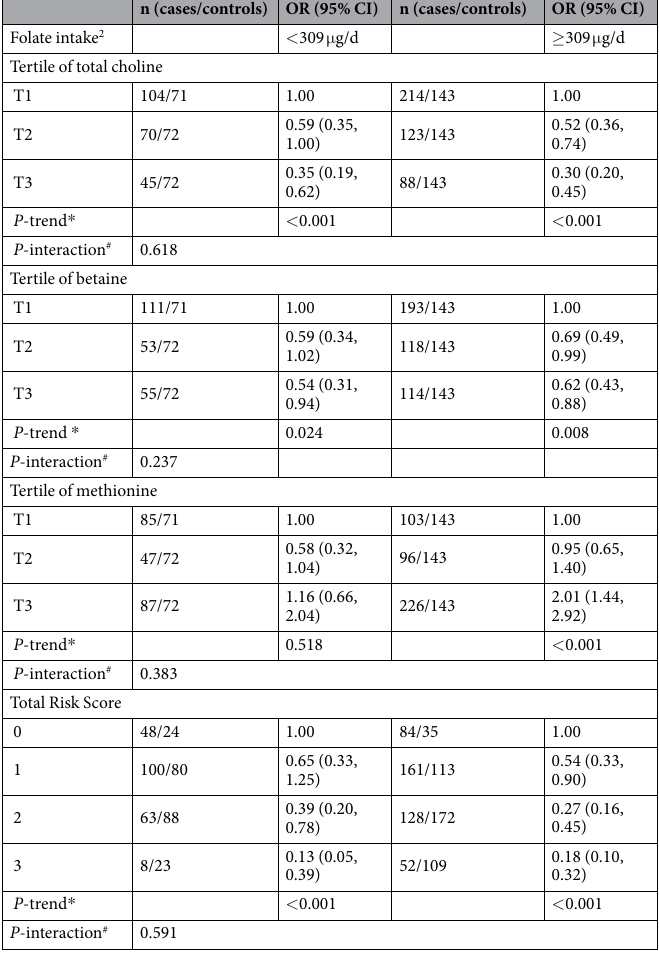
Table 4. Associations between the tertiles of total choline, betaine, methionine intake and primary liver cancer risk stratified by folate intake 1 . ORs (95% CIs): from multivariate unconditional logistic regression models. 1 Adjusted for the daily energy intake (ln-transformed), BMI, education level, occupation, household income, smoking, alcohol consumption, tea consumption, and physical activity. 2 Stratified according to the lowest tertile intake of folate in the controls. * α for p -trends = 0.05/6 (tests) = 0.0083. # α for p -interactions = 0.05/3 (tests) =